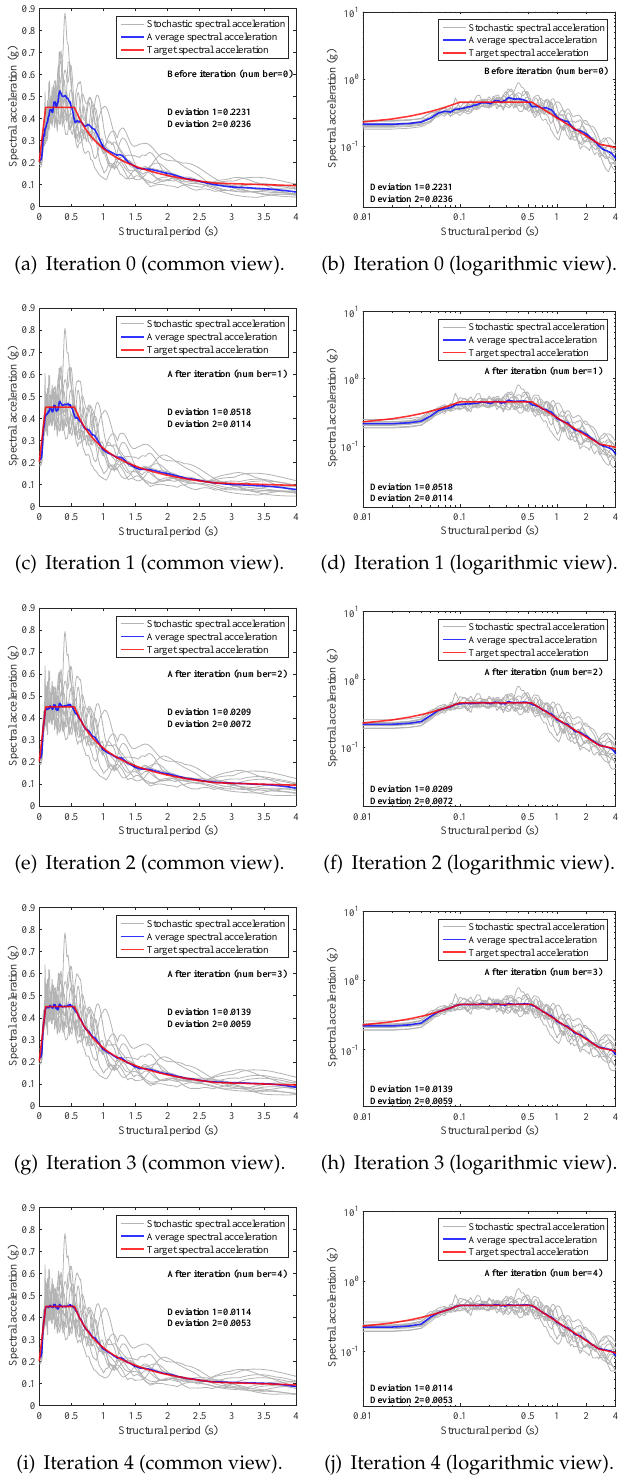
Figure 4. The individual, average and target spectral acceleration of all four iterative